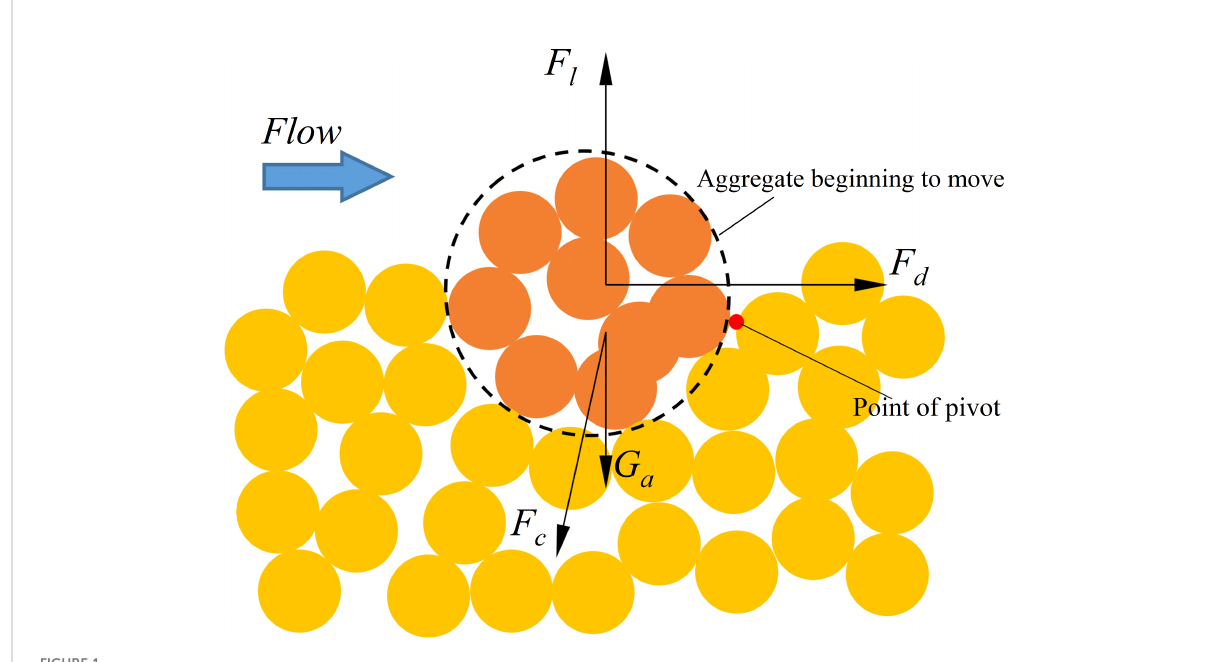
FIGURE 1 Aggregate at the water-sediment interface and force